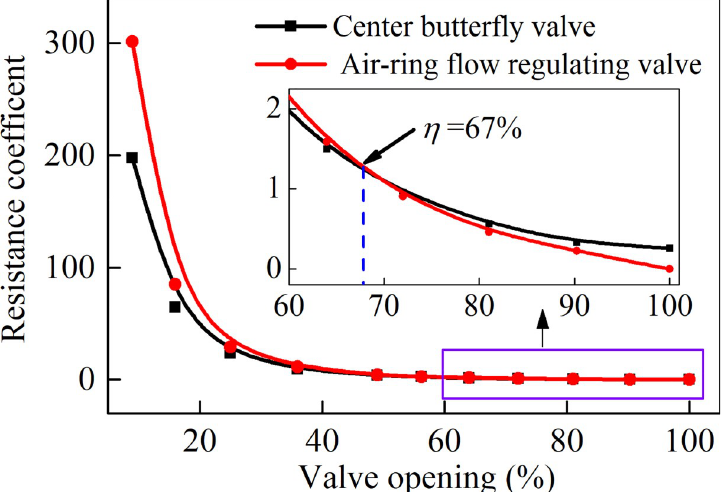
Fig 7. Comparison of resistance coefficient between the air-ring flow regulating valve and center butterfly